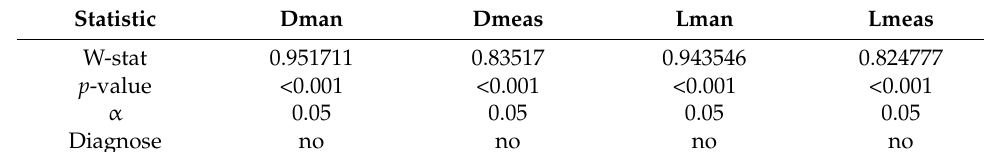
Figure A1. Results of the test for homoskedasticity (E1): ( a ) Plot of squared residuals against the predicted Dmeas (Note: data was homoskedastic by Breusch-Pagan test, p > 0.05); ( b ) Plot of squared residuals against the predicted Lmeas (Note: data was homoskedastic by Breusch-Pagan test, p > 0.05). Table A2. Results of normality check for the second experiment (E2).